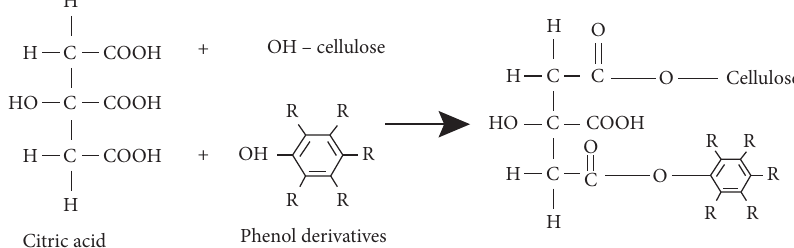
Figure 5: Mechanism of reaction between cellulose, citric acid, and phenolic compounds